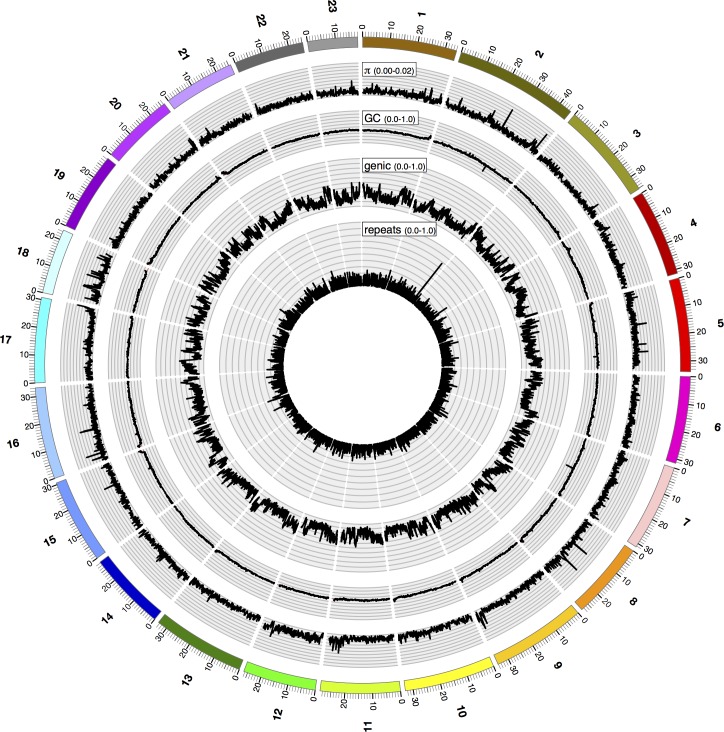
Sequence characteristics for each linkage group.Linkage groups are indicated on the outside. Small numbers indicate distances along each linkage group in Mb. Estimates for nucleotide diversity, π, GC content, and genic (exons and introns) and repeat density are averaged in 50 kb windows. Note that repeats can be located in genic regions.